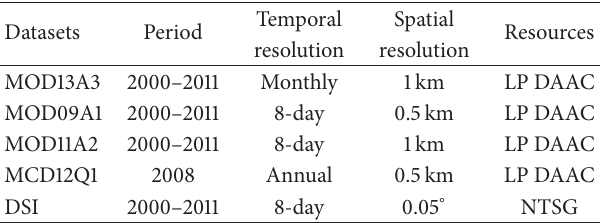
Table 1: MODIS datasets used in this study.